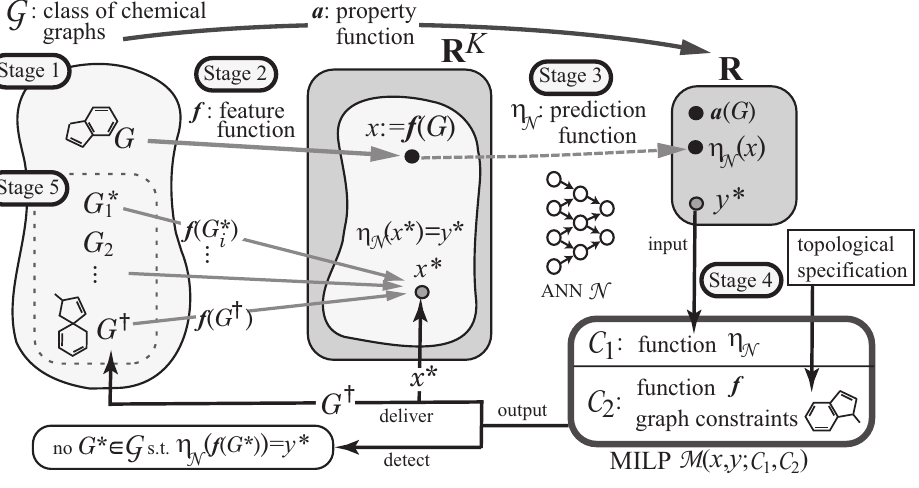
Figure 1. An illustration of a framework for inferring a set of chemical graphs G ∗ .